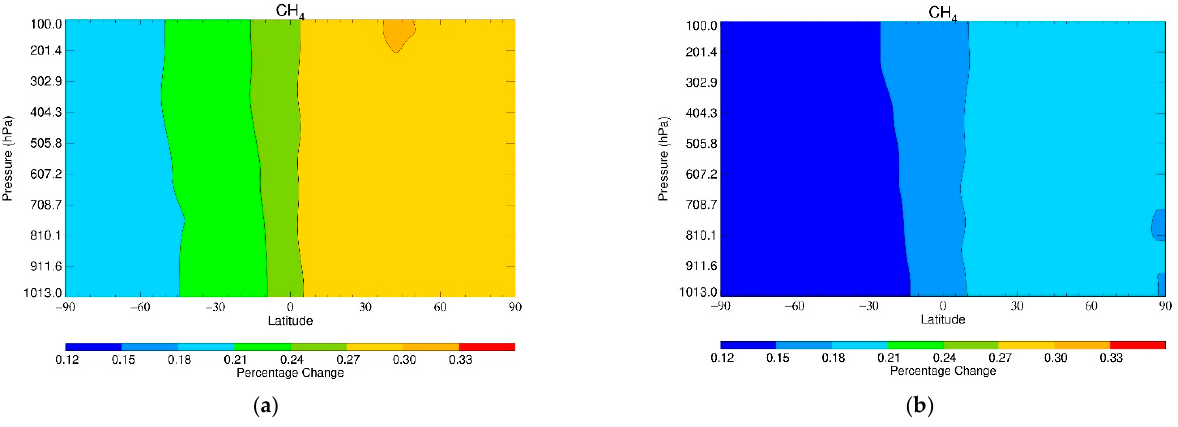
Figure 7. The percentage zonal change of CH 4 mixing ratios from ( a ) STOCHEM-base to STOCHEM- 75NO x scenario and ( b ) STOCHEM-base to STOCHEM-50NO x scenario. Note: The approximate height equivalent to the pressure in the y -axis can be found in Appendix A (Table A1).